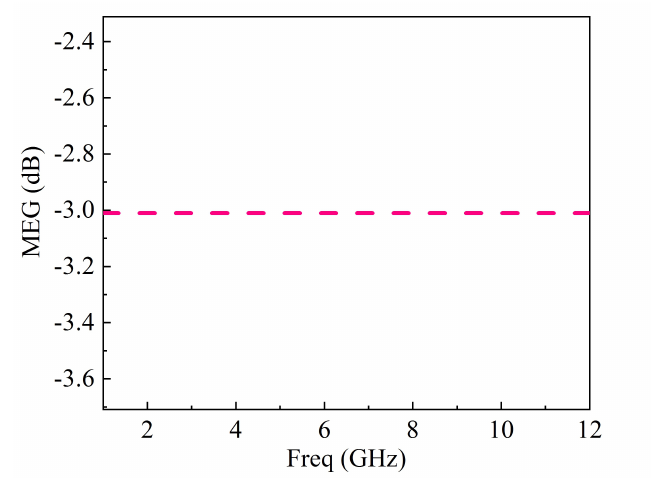
Figure 32. Mean effective gain (MEG) of the MIMO system. Table 3. Performance comparison with other antennas presented in the literature.